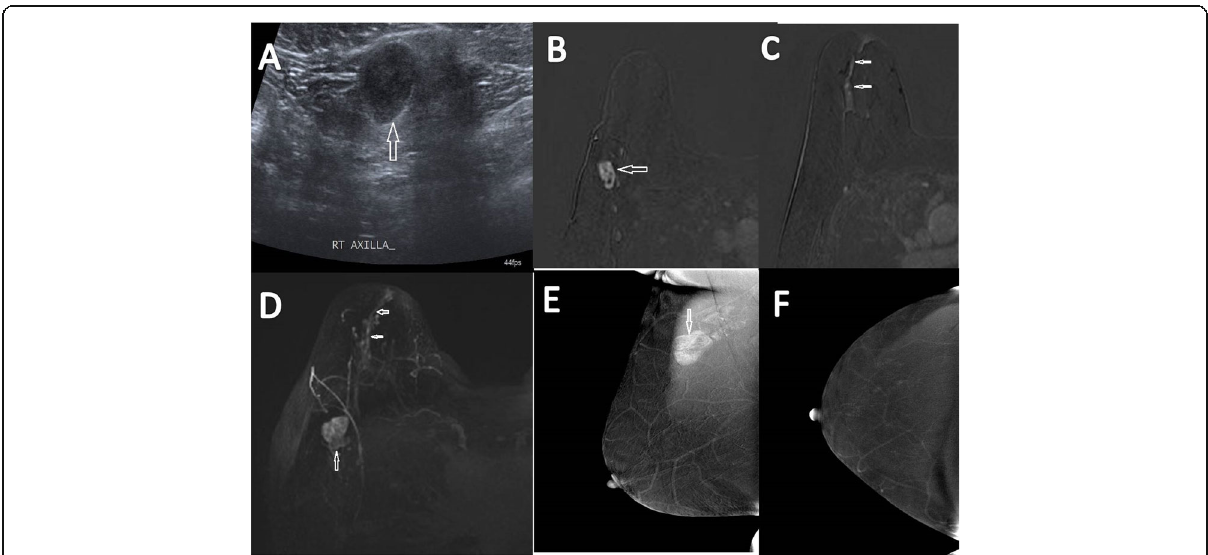
Fig. 6 Female patient 58 year old presented with right axillary swelling. On ultrasound ( a ), there was enlarged axillary lymph nodes with the loss of their normal fatty hilum and with a rounded appearance indicating pathological LNS (arrows), no lesion could be seen in breast in ultrasound or mammography. On MRI TIRM sequence ( b ), an enlarged right axillary LNS were seen (long arrow). On CE-MRI ( c ), there was evidence of intraductal linear enhancement directed towards the nipple (small arrows). On MIP MRI ( d ), the enlarged axillary LNS and ductal enhancement was clearly seen (arrows). On CESM ( e , f ), right axillary LNs was enhancing (arrow) while the ductal enhancement could not be seen. On histopathological correlation it was proven as DCIS with metastatic axillary LNS